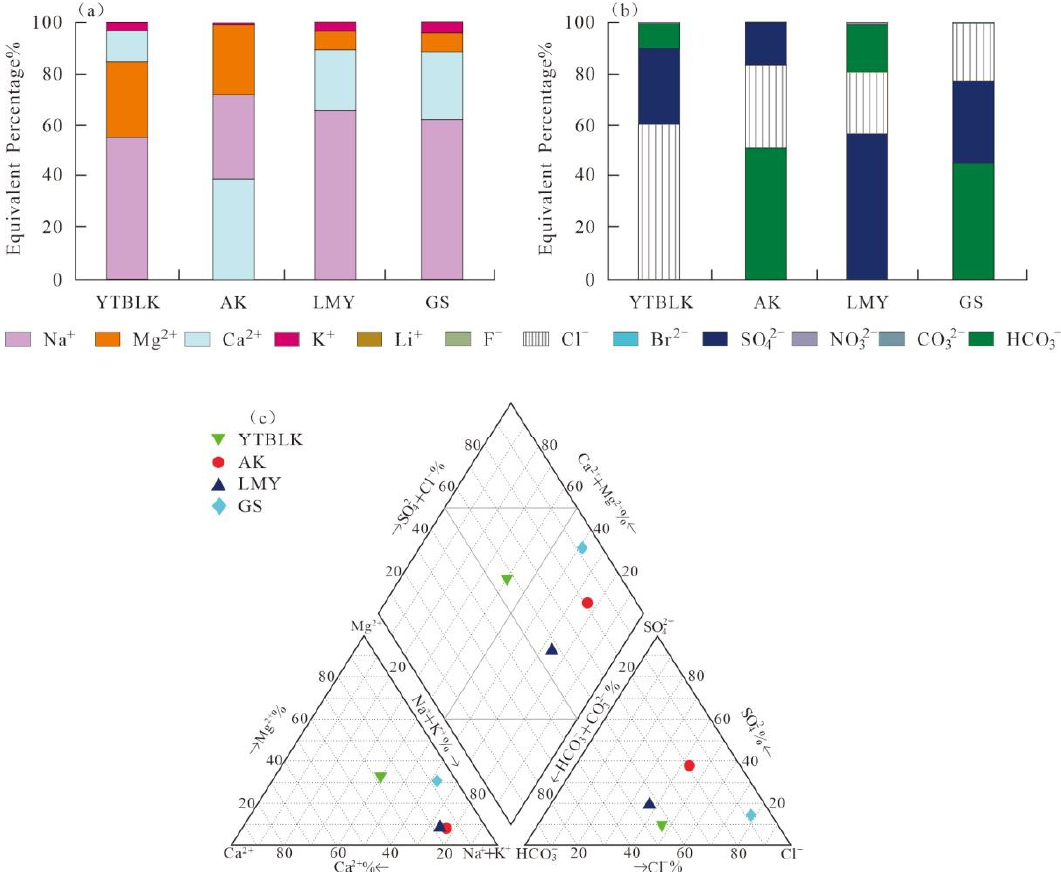
Figure 2. Ion concentration diagrams. ( a ) Percentage of major cations. ( b ) Percentage of major anions. ( c ) Piper diagram of sampling sites in study